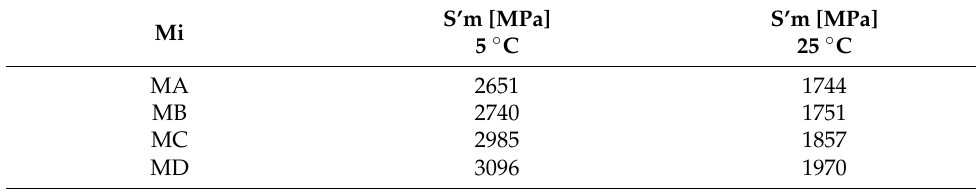
Table 2. Average stiffness moduli